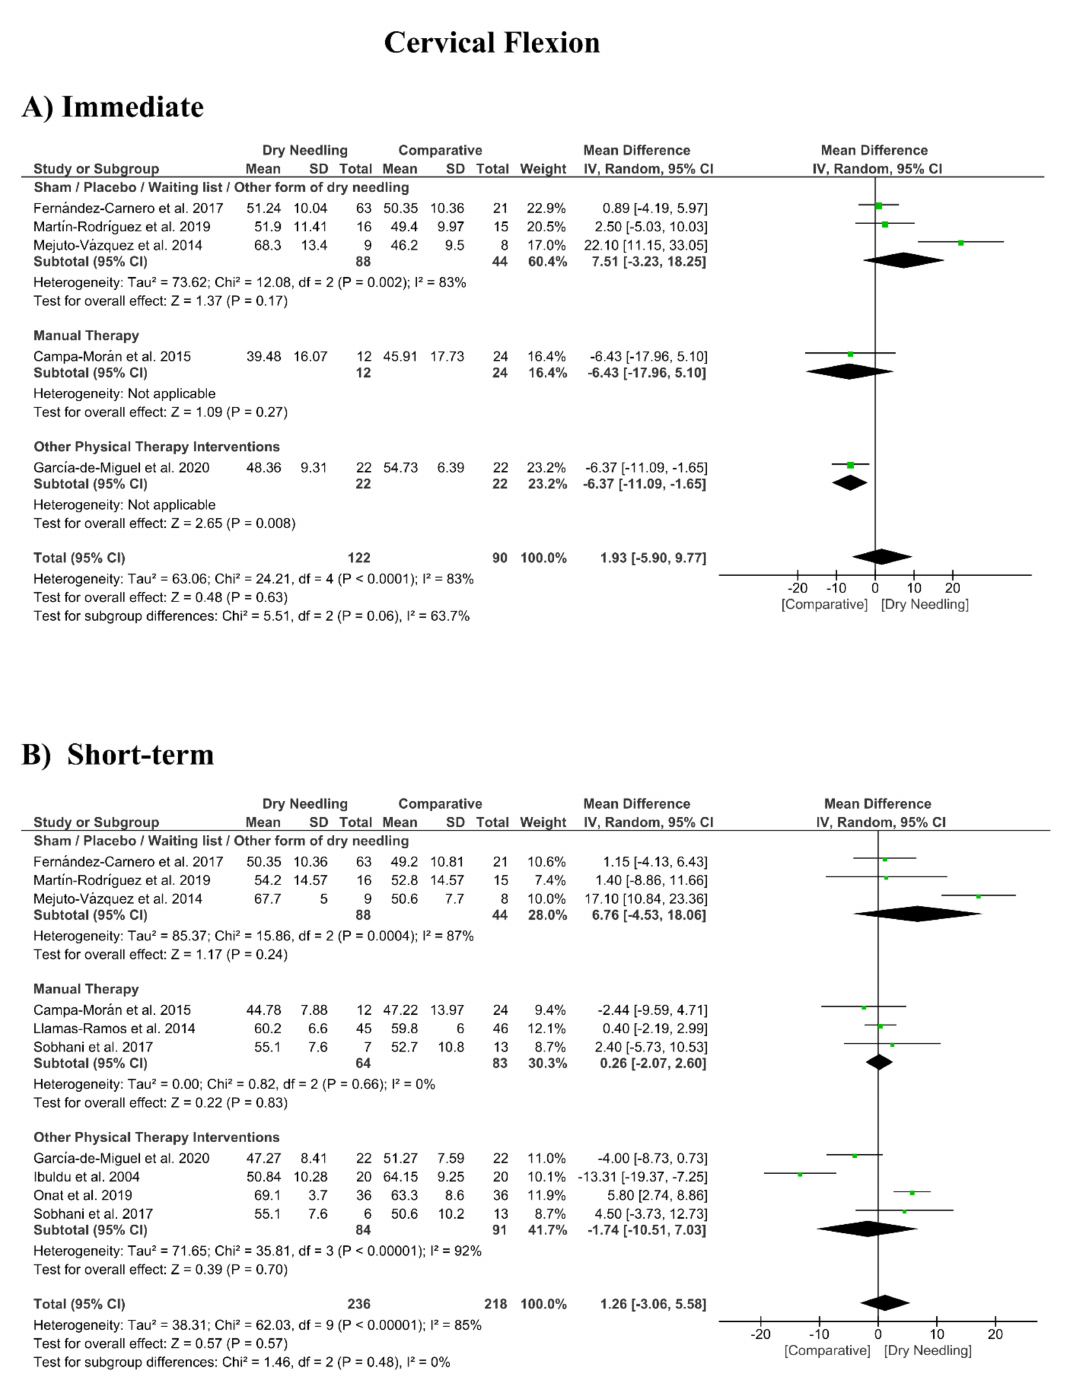
Figure 8. Mean di ff erences (MD) comparing the e ff ects of dry needling alone against sham / placebo / waiting list / other forms of dry needling or manual therapy or other physical therapy interventions on the cervical range of motion in flexion ( A ) immediately after and ( B ) at the short-term. SD: standard deviation; CI: confidence